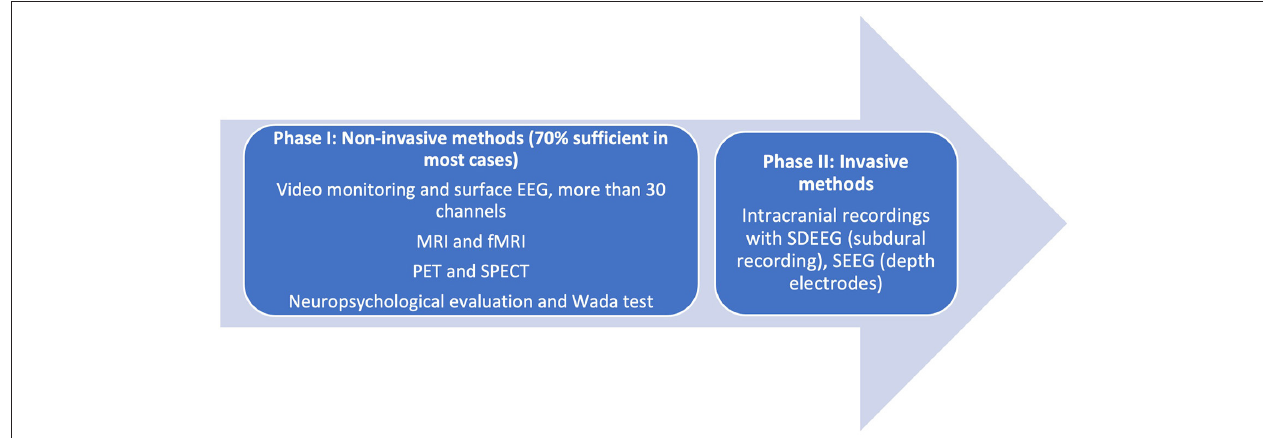
FIGURE 1 | Phases of presurgical evaluation of epilepsy. [Adapted from (12)]. EEG, electroencephalography; MRI, magnetic resonance imaging; fMRI, functional magnetic resonance imaging; SDEEG, Subdural electroencephalography; SEEG,